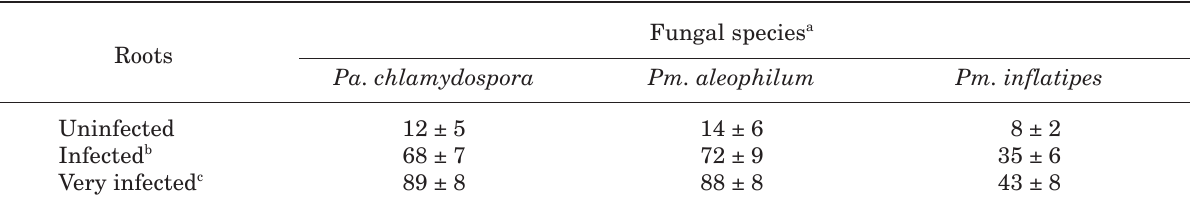
Table 2. Mycelial growth inhibition (%) of Phaeomoniella chlamydospora , Phaeoacremonium aleophilum and Pm. inflatipes grown with infected root extracts. Five ml of root extract (100 mg ml -1 dimethylsulphoxide, DMSO) was added to 100 ml of culture medium potato dextrose agar (PDA) of each fungus.